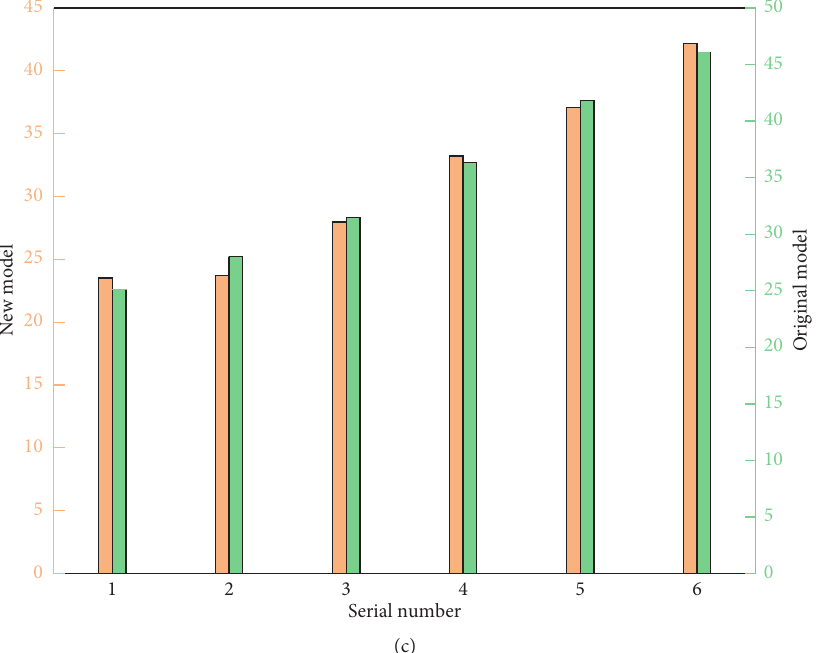
Figure 5: Performance comparison. (a) Inhomogeneous exponential sequence performance. (b) Approximately inhomogeneous expo- nential sequence performance. (c) Performance comparison chart.